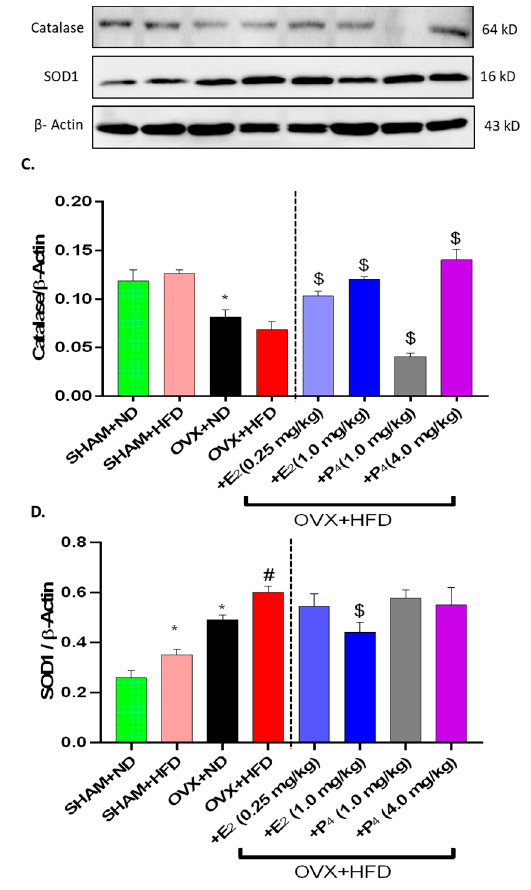
Figure 6. E ff ect of 17 β -Estradiol (E 2 ) and Progesterone (P 4 ) on oxidative stress-responsive enzymes Nrf2, and its Phase II enzyme induction in HFD-fed OVX mice. Representative immunoblot and densitometric analysis data for ( A ) Nrf2, ( B ) heme oxygenase 1 (HO-1), ( C ) catalase, and ( D ) superoxide dismutase (SOD) in female mice gastric neuromuscular tissues. Stripped blots were re-probed with β -actin. Data were normalized with housekeeping protein ( β -actin). Bar graphs showed a ratio of target gene or protein with β -actin. Data were analyzed using one-way ANOVA by using graph pad prism software. The values are mean ± SEM ( n = 4). * p < 0.05, significantly di ff erent from normal diet-fed sham-operated (SHAM + ND) mice. # p < 0.05, significantly di ff erent from normal diet-fed ovariectomized (OVX + ND) mice. $ p < 0.05, significantly di ff erent from high-fat diet-fed OVX (OVX + HFD) mice.